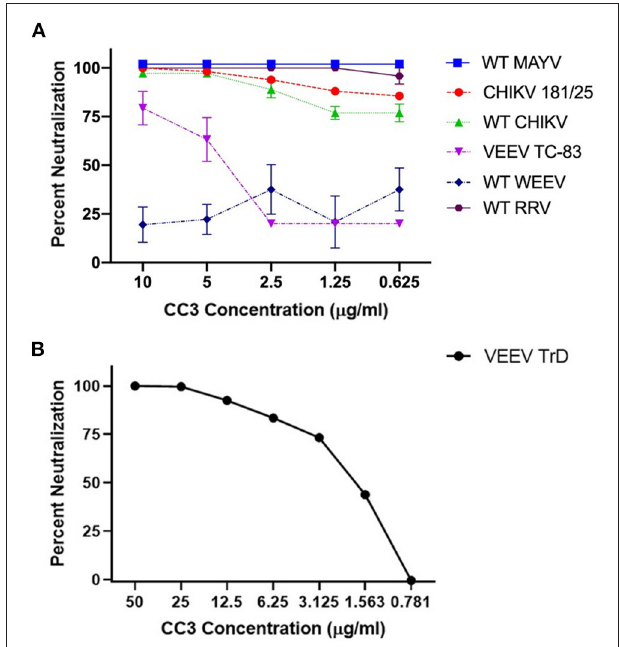
FIGURE 1 | Ability of clone CC3 to neutralize the indicated alphaviruses. (A) Shows neutralization of WT MAYV, CHIKV 181/25, WT CHIKV, VEEV TC-83, WT WEEV, and WT RRV. (B) Shows neutralization of WT Trinidad donkey (TrD) strain of